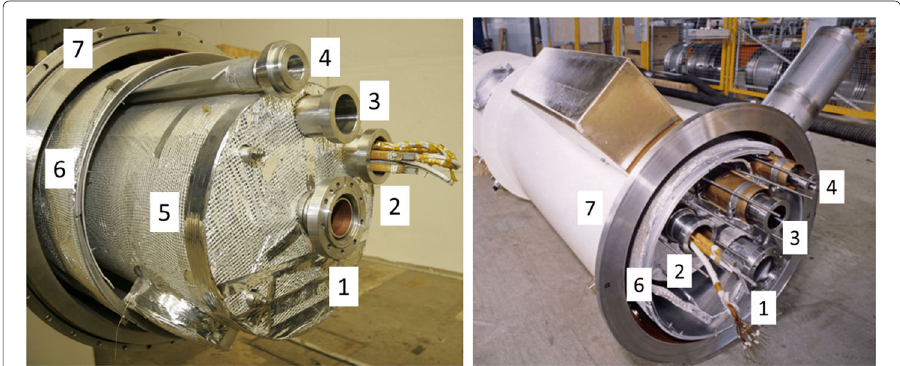
Fig. 5 View of the two ends of a HERA dipole. 1: Beam tube, 2: One phase Helium pipe with superconducting cables for the magnet coil, 3: Two phase Helium pipe, 4: Helium gas pipe for the cooling of the radiation shield, 5: Helium vessel containing the cold mass, 6: Radiation shield, 7: Vacuum